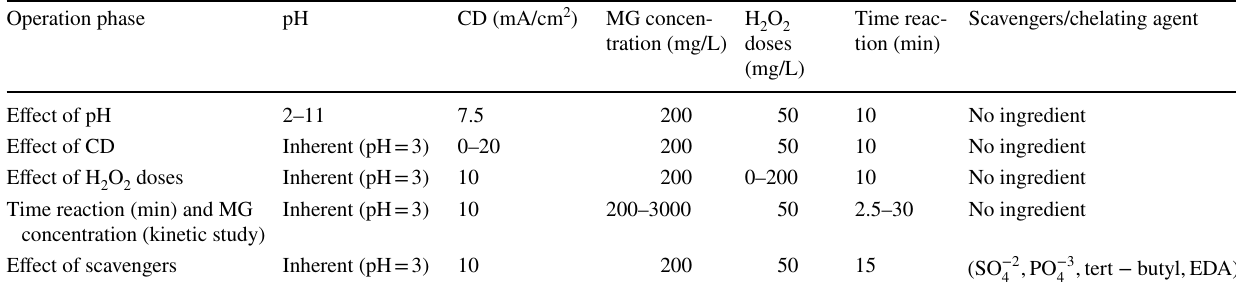
Table 1 The operation phases and experimental conditions Operation